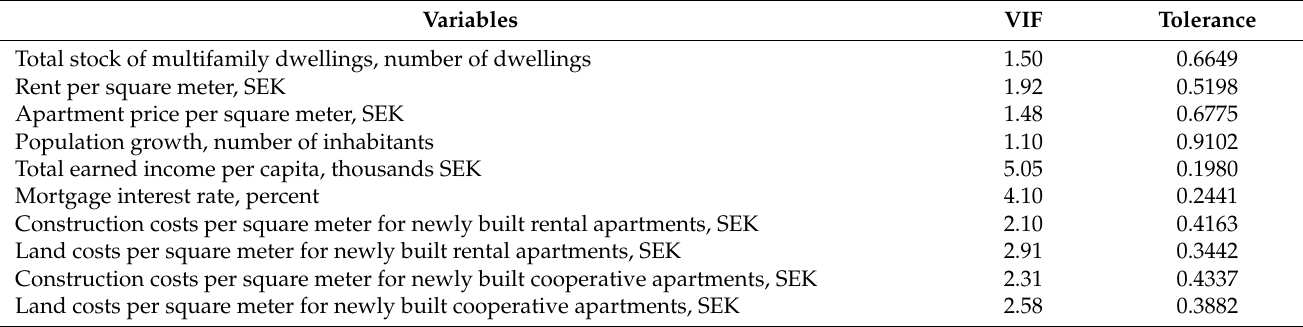
Table A4. Results of the VIF tests on variables in model 1.